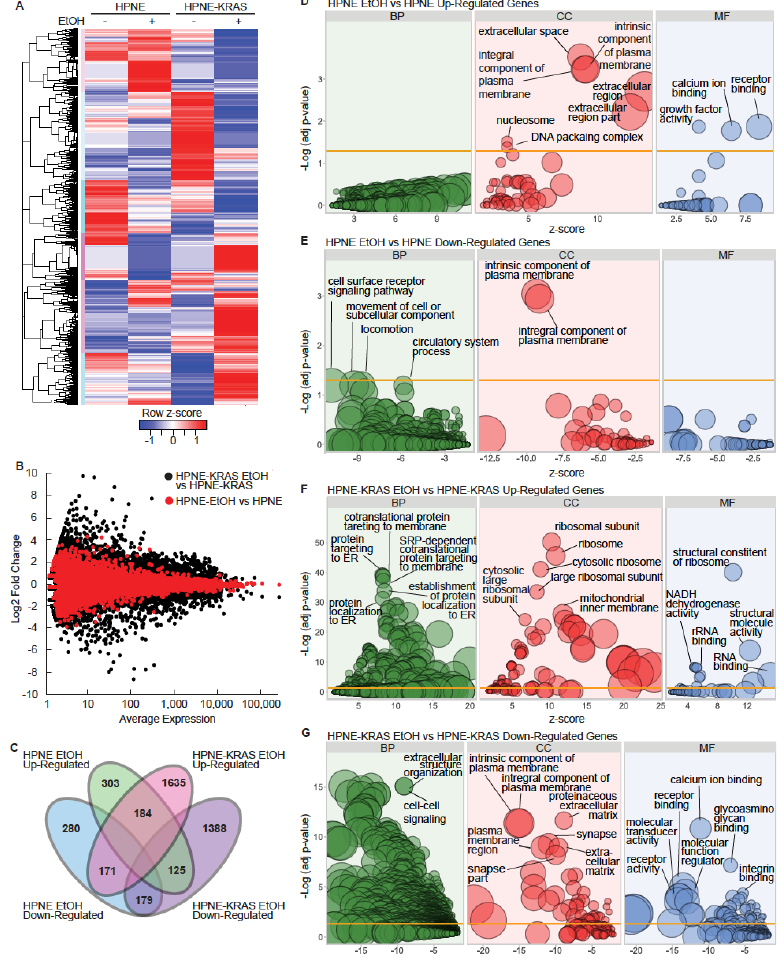
Figure 2. EtOH and KRAS status influence gene expression profiles in HPNE cells. ( A ) Heatmap of transcript expression values measured by RNA-Seq. ( n = 1). ( B ) MA plot showing the log ratio (M) versus the mean expression ( A ), across all conditions, of transcripts detected by RNA-Seq. ( C ) Venn diagram of differentially expressed protein coding transcripts. Protein coding transcripts that were ±2-fold different in the EtOH-conditioned cells compared to the untreated controls were considered differentially expressed. ( D – G ) Ethanol-conditioned cell lines were compared to untreated controls to identify up and downregulated protein coding genes (fold change = ±2) for GO term enrichment analysis. The DAVID bioinformatics tool was used to identify enriched terms for up or downregu- lated genes (analyzed independently). The z-score (x-axis) was calculated by z-score = (up − down)/sq (count), where up and down are the number of assigned genes upregulated or downreg- ulated in the data, and count is the number of genes assigned to a term. The bubble size is repre- sentative of the number of genes present in the respective term. FDR was used for the adjusted p - values.